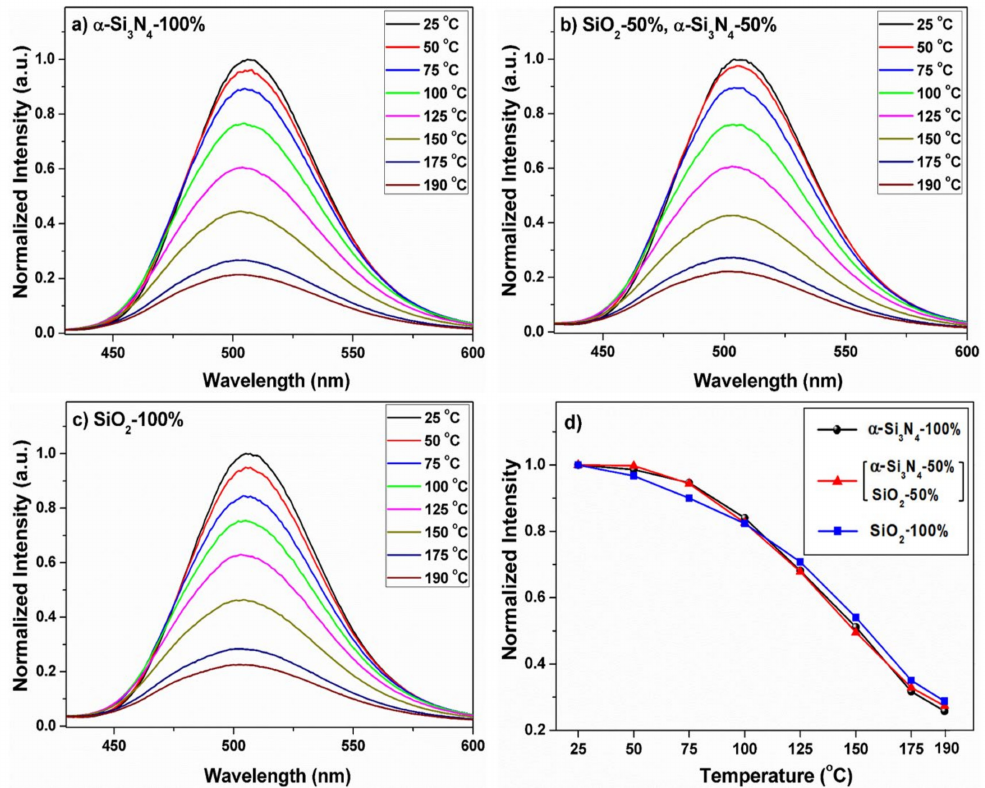
Figure 13. Temperature-dependent emission spectra of BSON:Eu 2 + phosphor synthesized using α -Si α -Si 3 N 4 –100% ( a ), SiO 2 –50% and 3 N 4 –50% ( b ), SiO 2 –100% ( c ) and the variation of maximum emission intensity from room-temperature to 190 ◦ C in the three phosphors ( d ). The PL intensity of phosphors at ambient temperature is fitted to 100%.